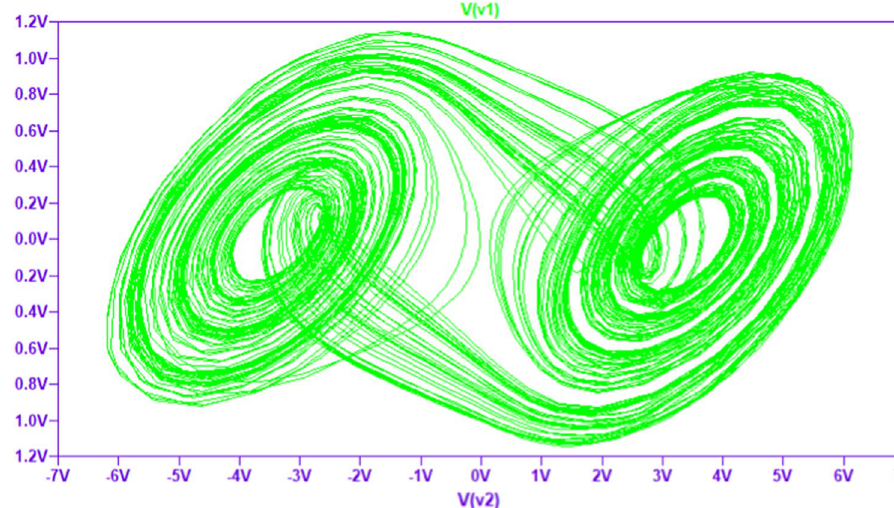
Fig. 7 Double scroll attractor for memristor U3 in Chua’s chaotic circuit with values R on = 0.8K R off = 1.65K R init = 1.65K